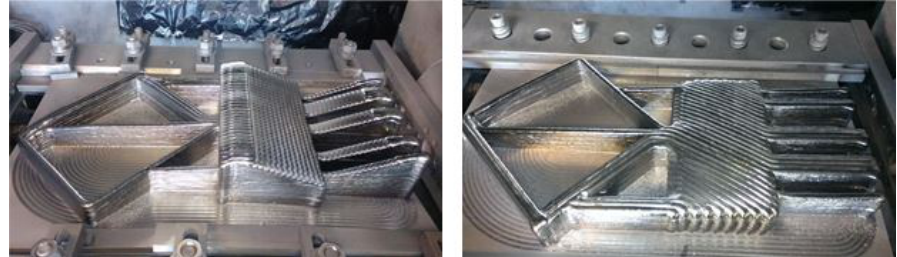
Figure 1. Electron beam additive manufacturing notional part geometry measuring 40 cm in width, 72 cm in length, and 18 cm in height; top ( left ) and bottom ( right